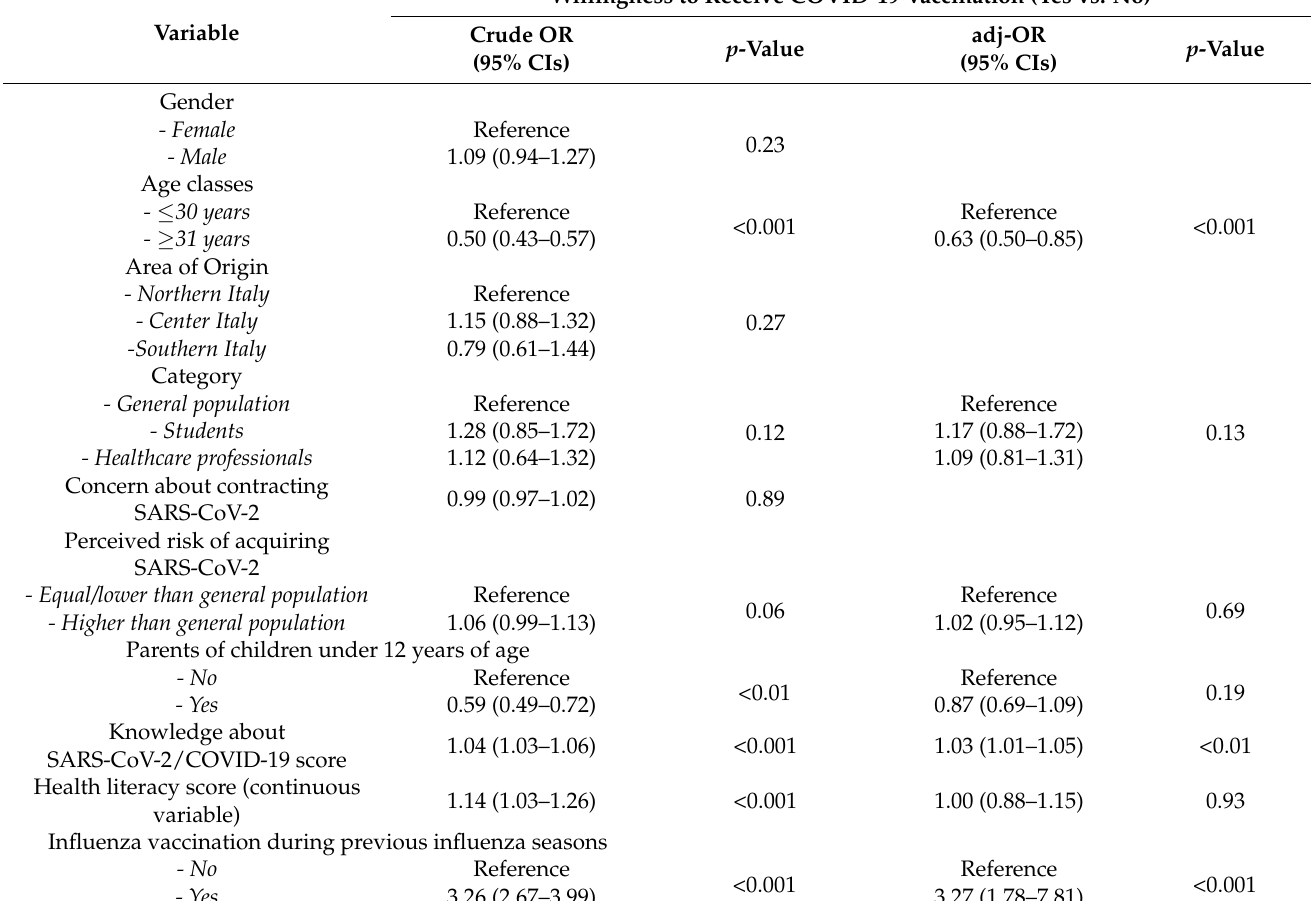
Table 5. Factors associated with willingness to accept COVID-19 vaccination in the univariable (crude OR) and multivariable (adj-OR) analyses. (adj-OR: adjusted odds ratio; 95% CI: confidence intervals